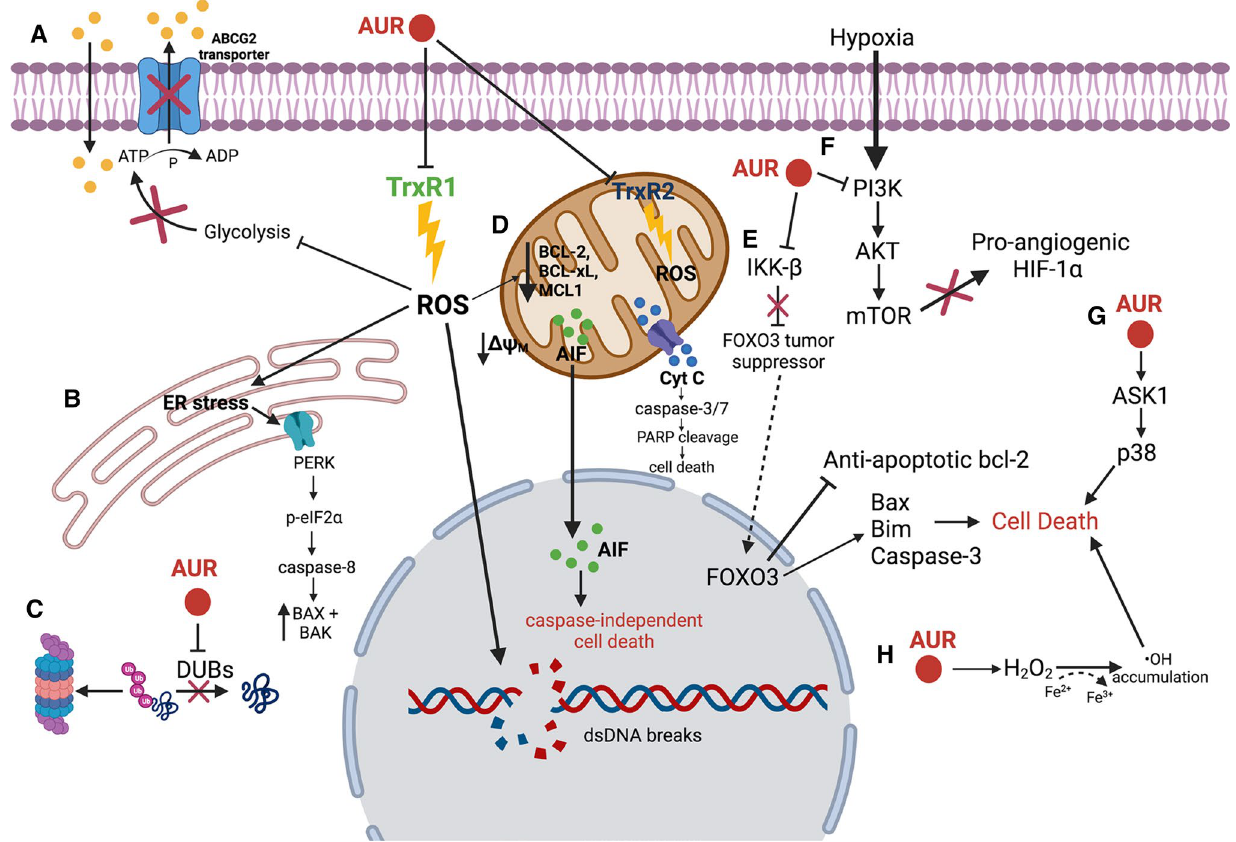
Fig. 2 Auranofin (AUR) inhibits the anti-oxidant enzymes thioredoxin reductase 1 (TrxR1) and 2 (TrxR2) resulting in an increase in the level of intracellular reactive oxygen species (ROS), mitochondrial permeability, and DNA damage. A AUR inhibits glycolysis resulting in reduced ATP levels and inhibition of the function of drug transporter, ABCG2, preventing development of drug resistance. B AUR-mediated ROS pro- duction causes ER stress and PERK activation, leading to cell death. C AUR inhibits the function of deubiquitinases enzymes (DUBs) in pro- tein homeostasis and induction of tumor growth. D Increased ROS induced by AUR causes decreased membrane potential in the mitochon- drial membrane, resulting in a decrease in anti-apoptotic proteins, caspase-dependent cell death, and translocation of apoptosis-inducing factor (AIF) into the nucleus to trigger caspase-independent cell death. E AUR inhibits the IKK-β signaling pathway, which normally induces FOXO3 tumor suppressor degradation. The inhibition of IKK-β by AUR allows the nuclear translocation of FOXO3, activating proapoptotic proteins, resulting in cell death. F AUR inhibits the PI3K/AKT/mTOR pathway, resulting in the inhibition of pro-angiogenic factors like HIF-1α, preventing tumorigenesis. G AUR activates ASK1 leading to p38-mediated cell death. H AUR promotes the conversion of H Fenton reaction, resulting in the induction of cell